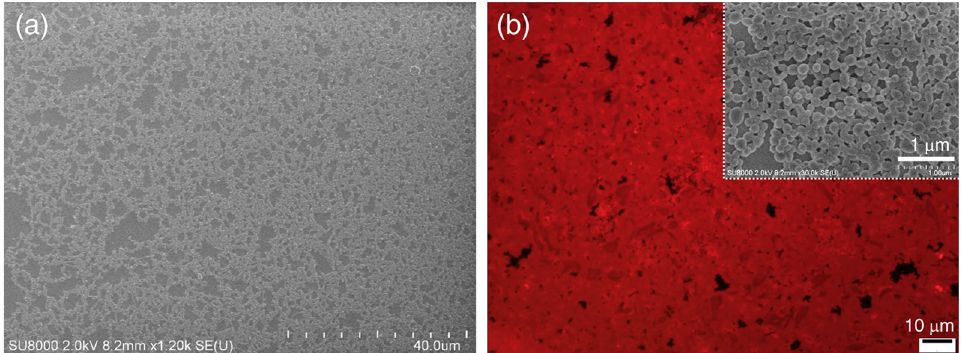
Figure 5. ( a ) Mesh-like network (SEM) and ( b ) red fluorescent 2D sheet (fluorescence optical mi- croscopy (FOM)) structures obtained from the PEG2000:Bu mixed system ( f PEG2000 = 80%). The inset photograph in ( b ) is a magnified SEM image of a sheet.